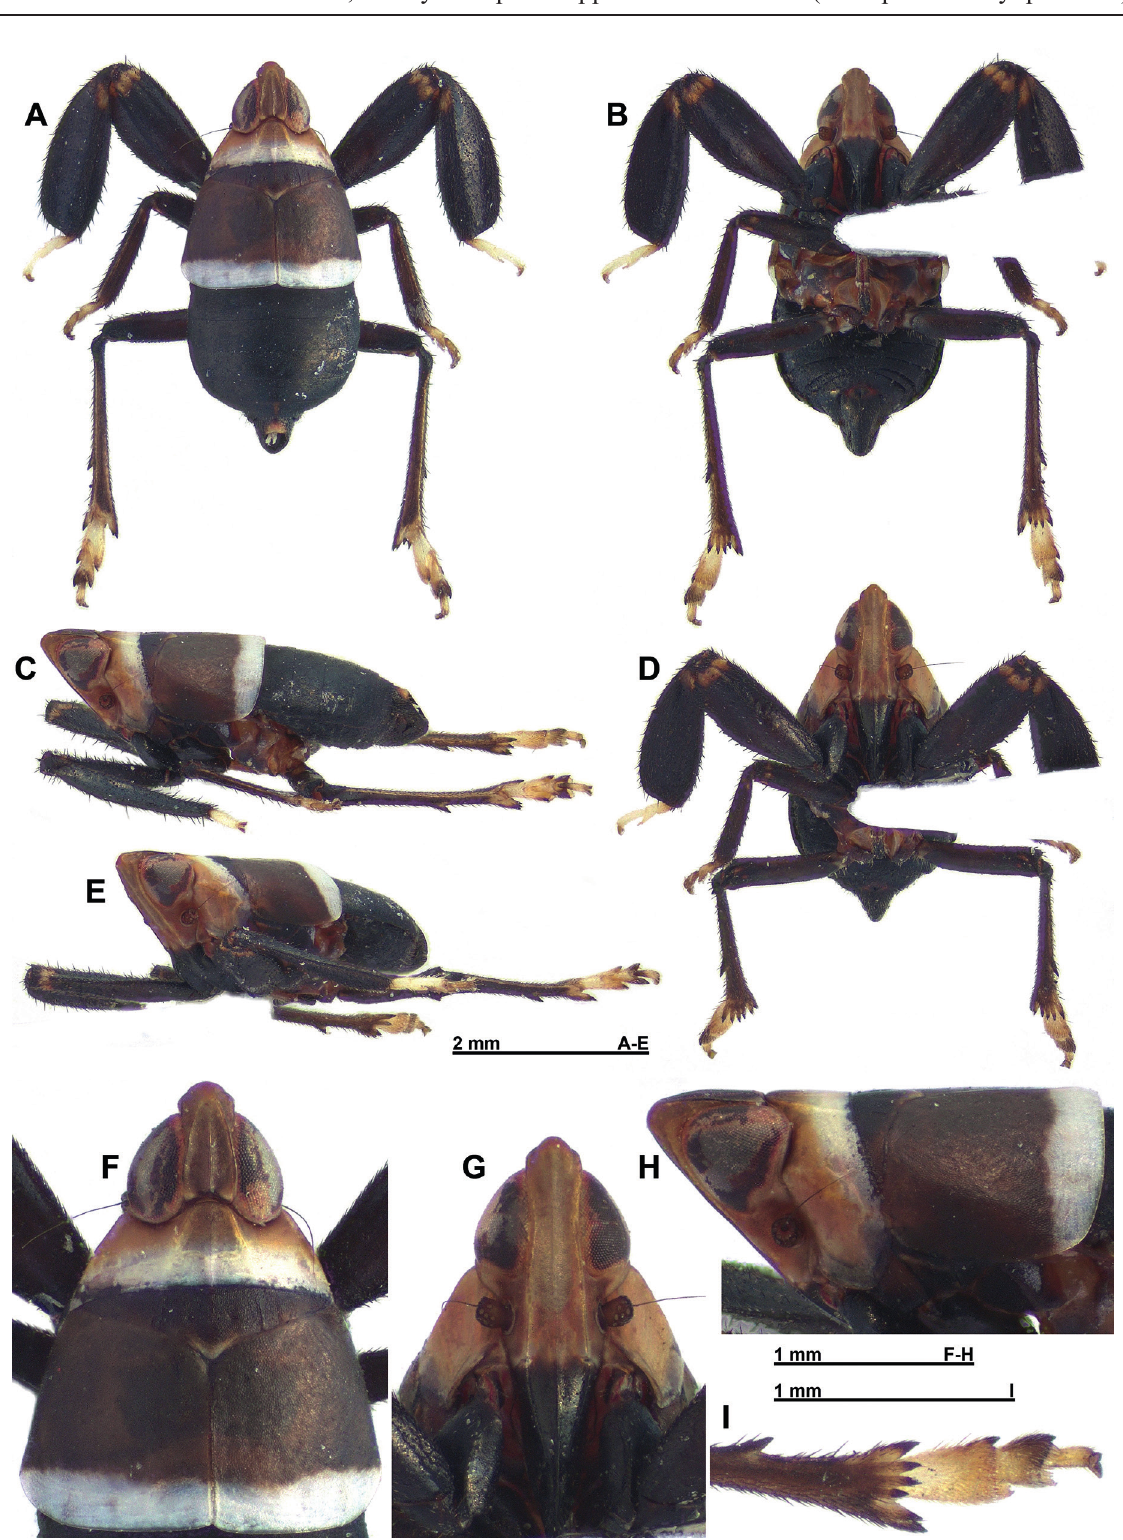
Fig. 7. Cleotyche ( Cleotyche ) francescoi sp. nov., ♂, holotype (QM). A . Habitus dorsal view. B . Habitus, ventral view. C . Habitus, lateral view. D . Habitus, perpendicular view of frons. E . Habitus, anterolateral view. F . Head and thorax, dorsal view. G . Frons, perpendicular view. H . Head and thorax, lateral view. I . Distal portion of posterior leg, ventral